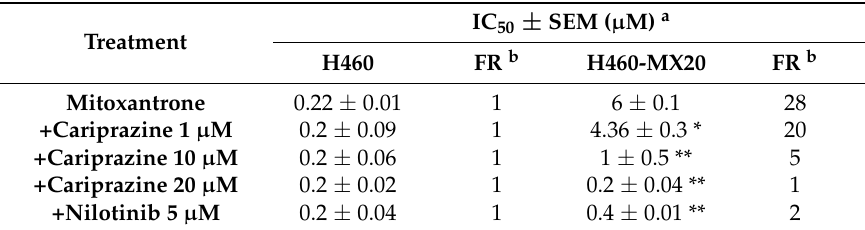
Table 1. The effect of cariprazine and nilotinib on the cytotoxicity of MX in ABCG2-overexpressing H460-MX20 cells.